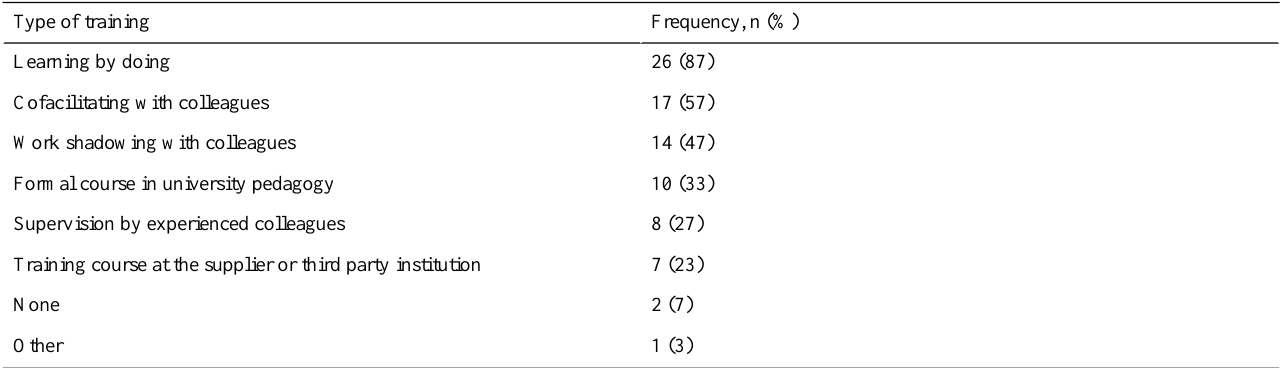
Table 3. Types of training received (multiple selections per respondent;